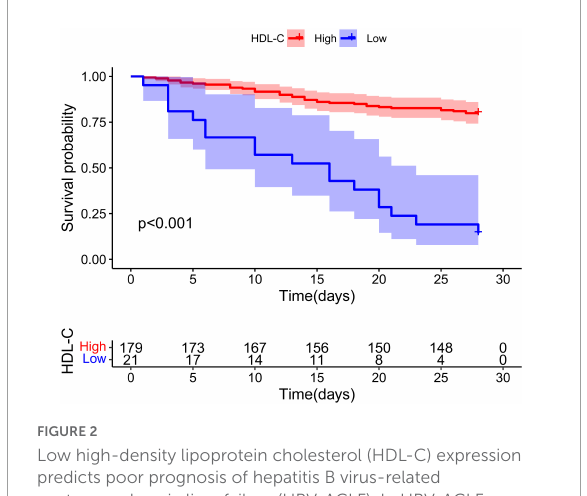
FIGURE2 Low high-density lipoprotein cholesterol (HDL-C) expression predicts poor prognosis of hepatitis B virus-related acute-on-chronic liver failure (HBV-ACLF). In HBV-ACLF patients, the cumulative survival rates of the HDL-C low expression group and high expression group were analyzed by Kaplan–Meier curve, and the difference in cumulative survival rates between groups was determined by the log rank test.